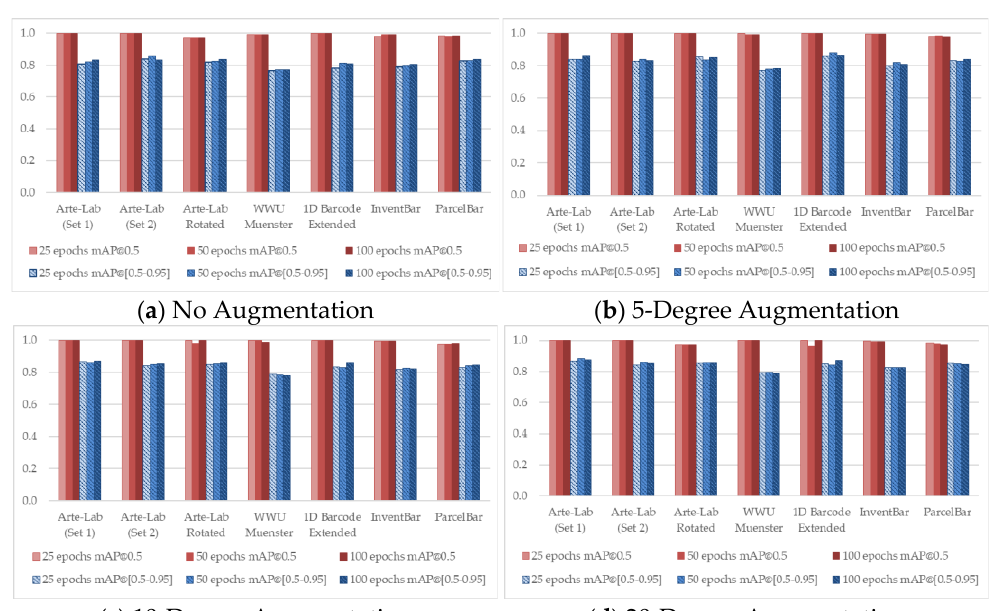
Figure 6. Recognition rate of RetinaNet applied over seven public barcode datasets.